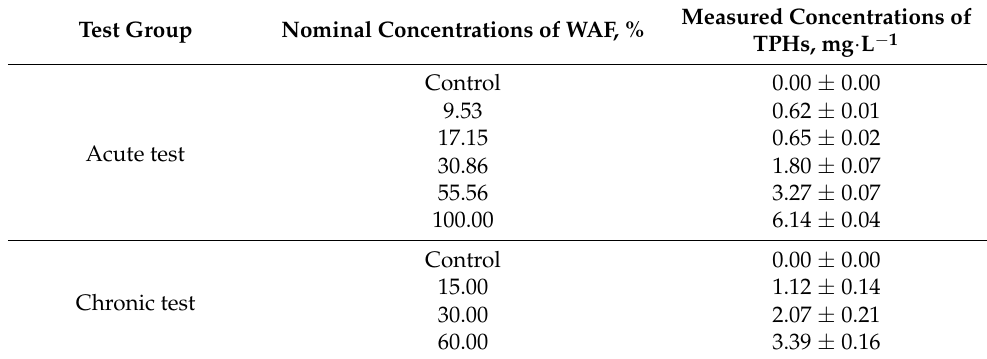
Table 1. Nominal concentrations of WAFs and measured concentrations of TPHs ( n = 3).